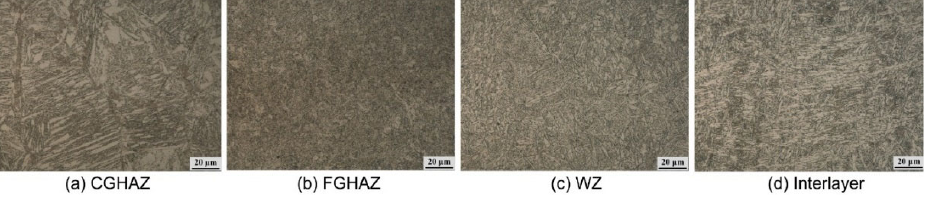
Figure 5. Microstructure of the welded joint with the welding speed of 300 mm/min. ( a ) coarse ‐ grain heat ‐ affected zone; ( b ) fine ‐ grain heat ‐ affected zone; ( c ) weld zone; ( d ) interlayer zone.